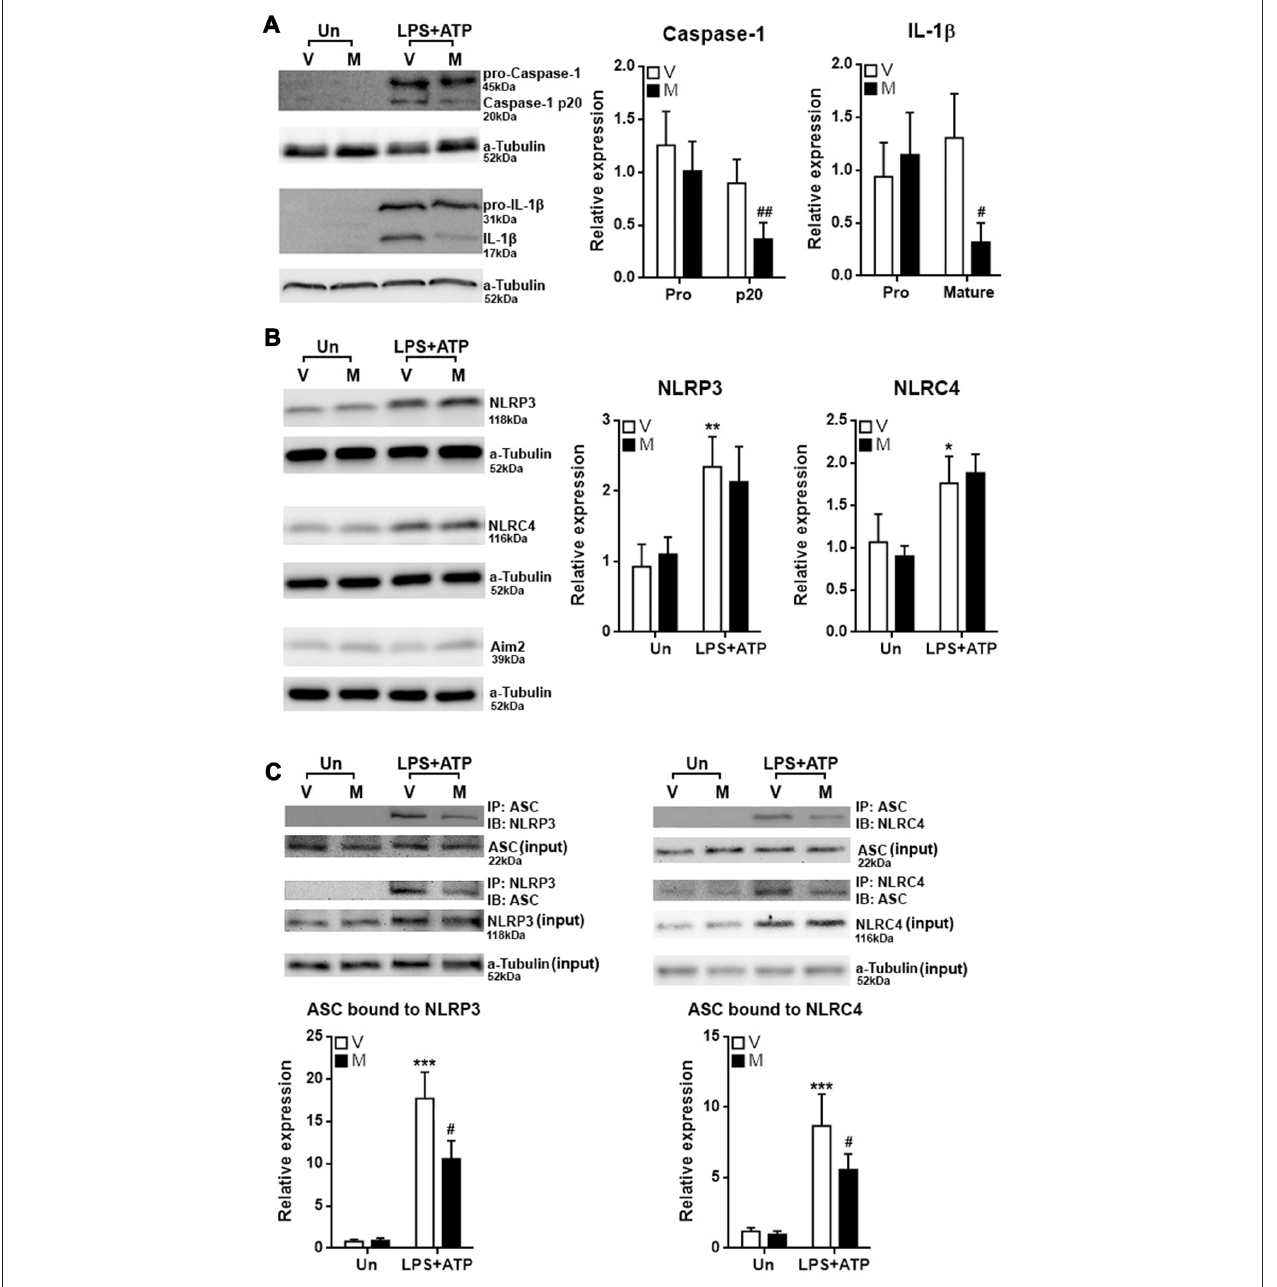
FIGURE 3 | Methylene blue inhibits inflammasome formation in cultured microglia. (A) Expression of Pro-Caspase-1, Caspase-1 p20, pro-IL-1 β and mature IL-1 β in microglia with or without stimulation in the presence or absence of methylene blue. Left: representative Western blot images. Right: statistics. N = 5 per group. The (B) expression of NLRP3, NLRC4 and Aim2 in microglia. Left: representative Western blot images. Right: statistics. N = 4 per group. (C) Co-immunoprecipitation assay showing the binding of ASC to NLRP3 or NLRC4. Left: representative Western blot images. Right: statistics. Un: no stimulation. LPS+ATP: stimulation with LPS followed by ATP treatment. V: vehicle; M: 500 nM methylene blue. IP: immunoprecipitation with the antibody against indicated protein. IB: detection of indicated protein. To analyze the relative expression of target proteins, the band intensities of target proteins were normalized to corresponding band intensities of α -Tubulin, followed by calculating the expression in other groups relative to “Un (V)” group. N = 4 per group. ∗ p < 0.05; ∗∗ p < 0.01; ∗∗∗ p < 0.001 in comparison with unstimulated cells of the vehicle group. # p < 0.05; ## p < 0.01 in comparison with stimulated cells of the vehicle group.